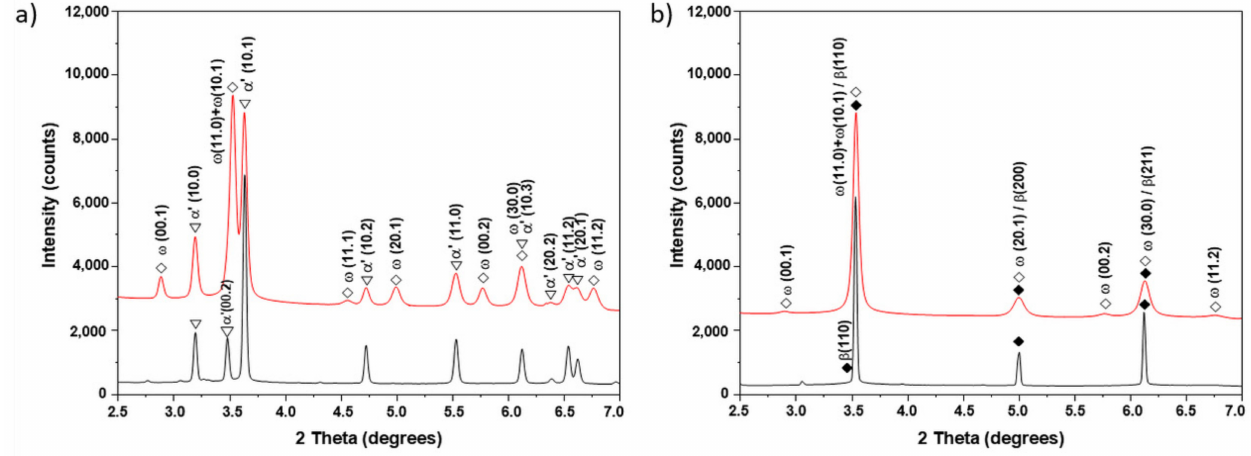
Figure 11. Synchrotron XRD curves of the Ti–2wt.% Mo ( a ) and Ti–18wt.% Mo ( b ) alloys before (black curves) and after HPT (red